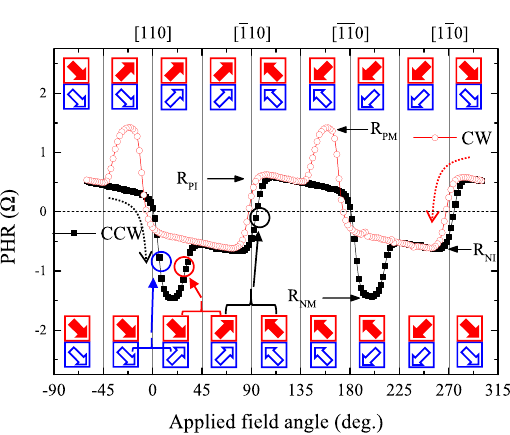
Figure 5. Angular dependences of PHR data obtained at 3 K by rotating magnetic a field of 200 Oe in the sample plane. The open and solid symbols show results obtained with clockwise (CW) and counterclockwise (CCW) field rotations, respectively. Thick solid (red) and open (blue) arrows indicate magnetization orientations in GaMnAs layers with positive and negative Δ R ,